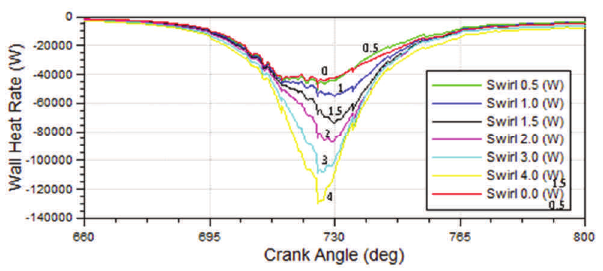
Fig. 7. Heat rate through combustion chamber walls at different crank ankle positions